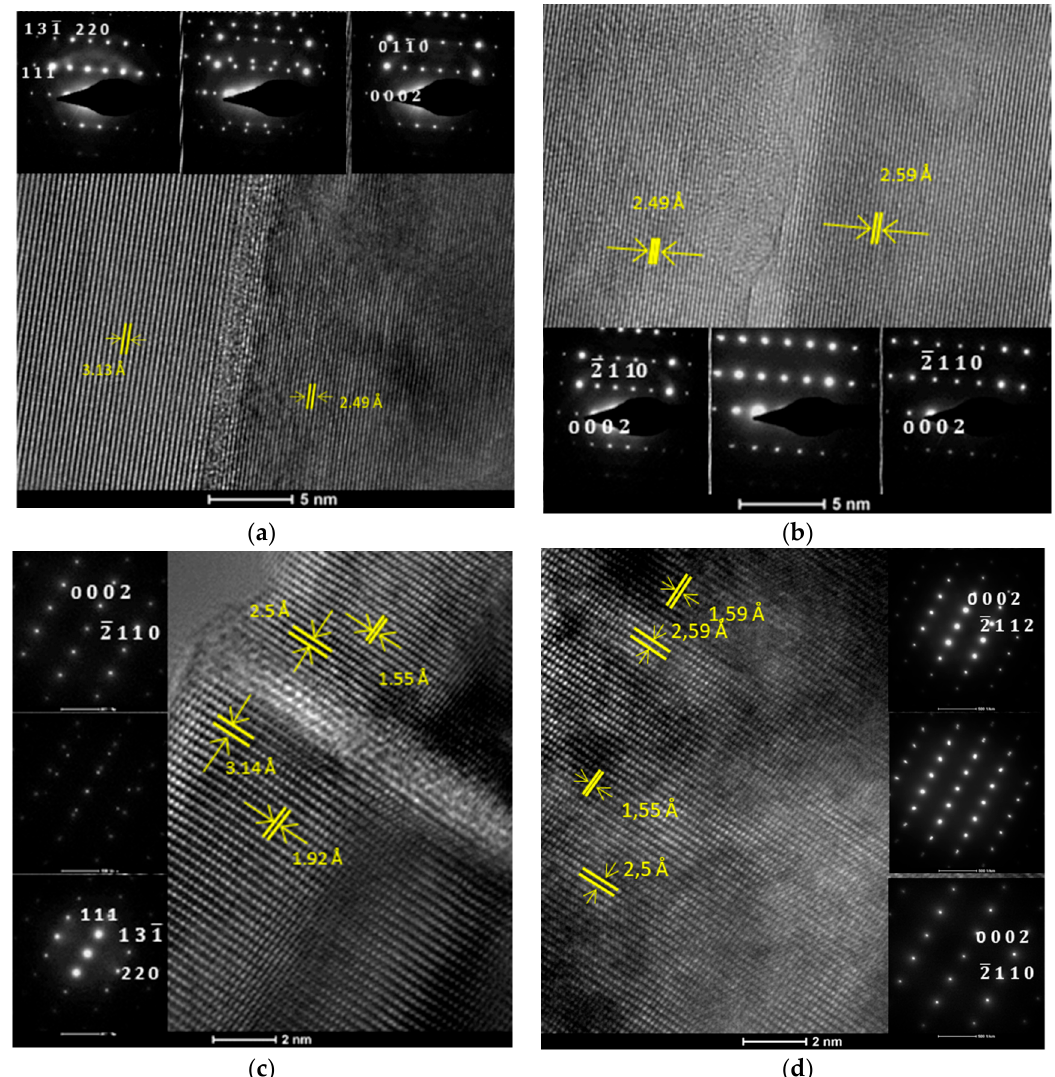
Figure 1. High-resolution transmission electron microscopy (HR-TEM) micrographs and selected area electron diffraction (SAED) patterns showing the display of atom planes in respect to their respective interfaces for: ( a ) GaN300/Si–Si/AlN interface, ( b ) GaN300/Si–AlN/GaN interface, ( c ) GaN700/Si–Si/AlN interface, ( d ) GaN700/Si–AlN/GaN interface.